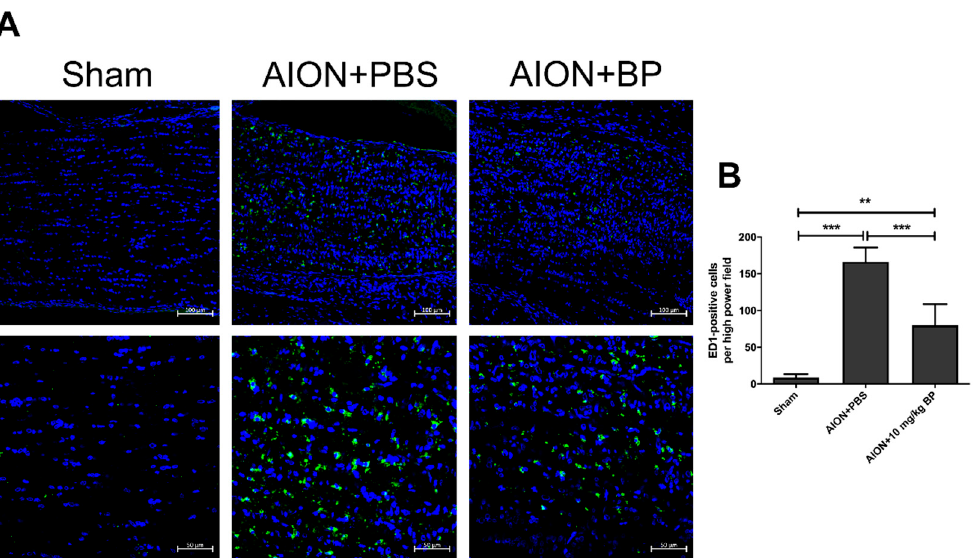
Figure 6. Immunostaining in the ON with ED1 antibody. ED1 immunostaining image of ON tissue in each group. The upper rows represent 10 × magnification and the lower rows represent high (20 × ) magnification in the same specimen. ( A ). Quantitative analysis of ED1-positive cells (green) in the sham, PBS-treated, and BP-treated groups revealed 8.7 ± 4.8, 166.4 ± 19.3, and 80.1 ± 28.9 cells/HPF, respectively ( B ) (***, p ≤ 0.001; **, p ≤ 0.01; n = 6. The upper column of scale bar = 100 µ m, the lower column of scale bar = 50 µ m).